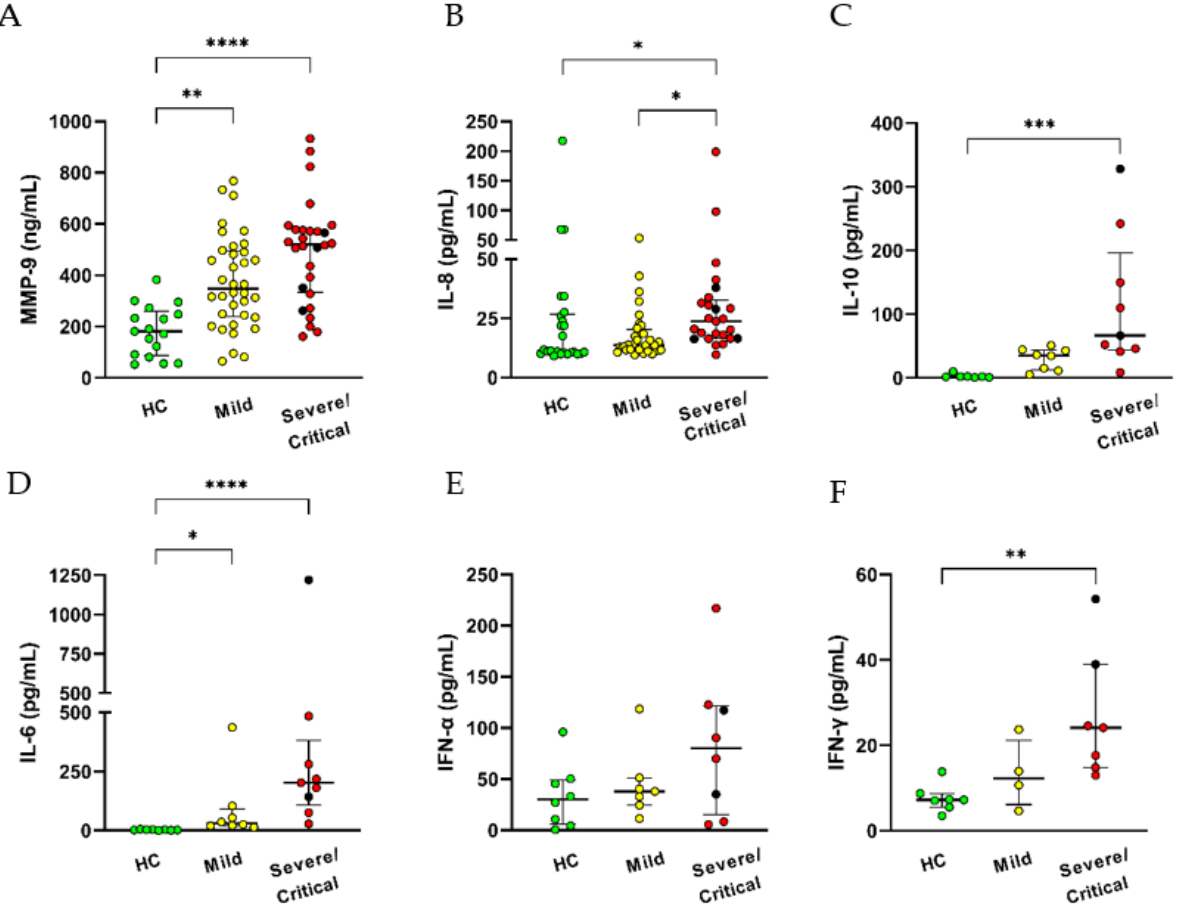
Figure 4. Increased pro-inflammatory cytokines levels with COVID-19 severity. Evaluation of cytokines in serum were analyzed by ELISA: ( A ) MMP-9 and ( B ) IL-8 were evaluated in healthy control HC = 17–25 and patients with Mild = 32–36, Severe = 2–4, Critical = 21–24 and ( C ) IL-10, ( D ) IL-6, ( E ) IFN- α d and ( F ) IFN- γ were evaluated in HC = 7–8, Mild = 7–8, Severe = 2, Critical = 7. Black circles are represented by severe, and red circles by critical patients. Data shows median and interquartile range. * p ≤ 0.05, ** p ≤ 0.01, *** p ≤ 0.001 and **** p ≤ 0.0001.